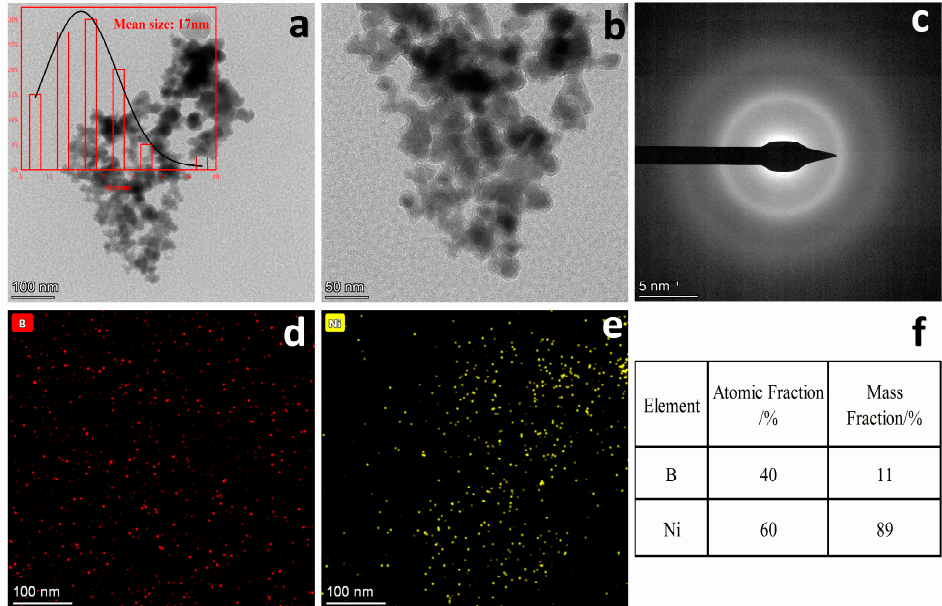
Figure 3. TEM images of Ni 12.4 -30 catalyst: ( a ) 100 nm. ( b ) 50 nm. ( c ) SAED pattern. ( d ) Elemental mapping of B. ( e ) Elemental mapping of Ni. ( f ) Elemental composition.